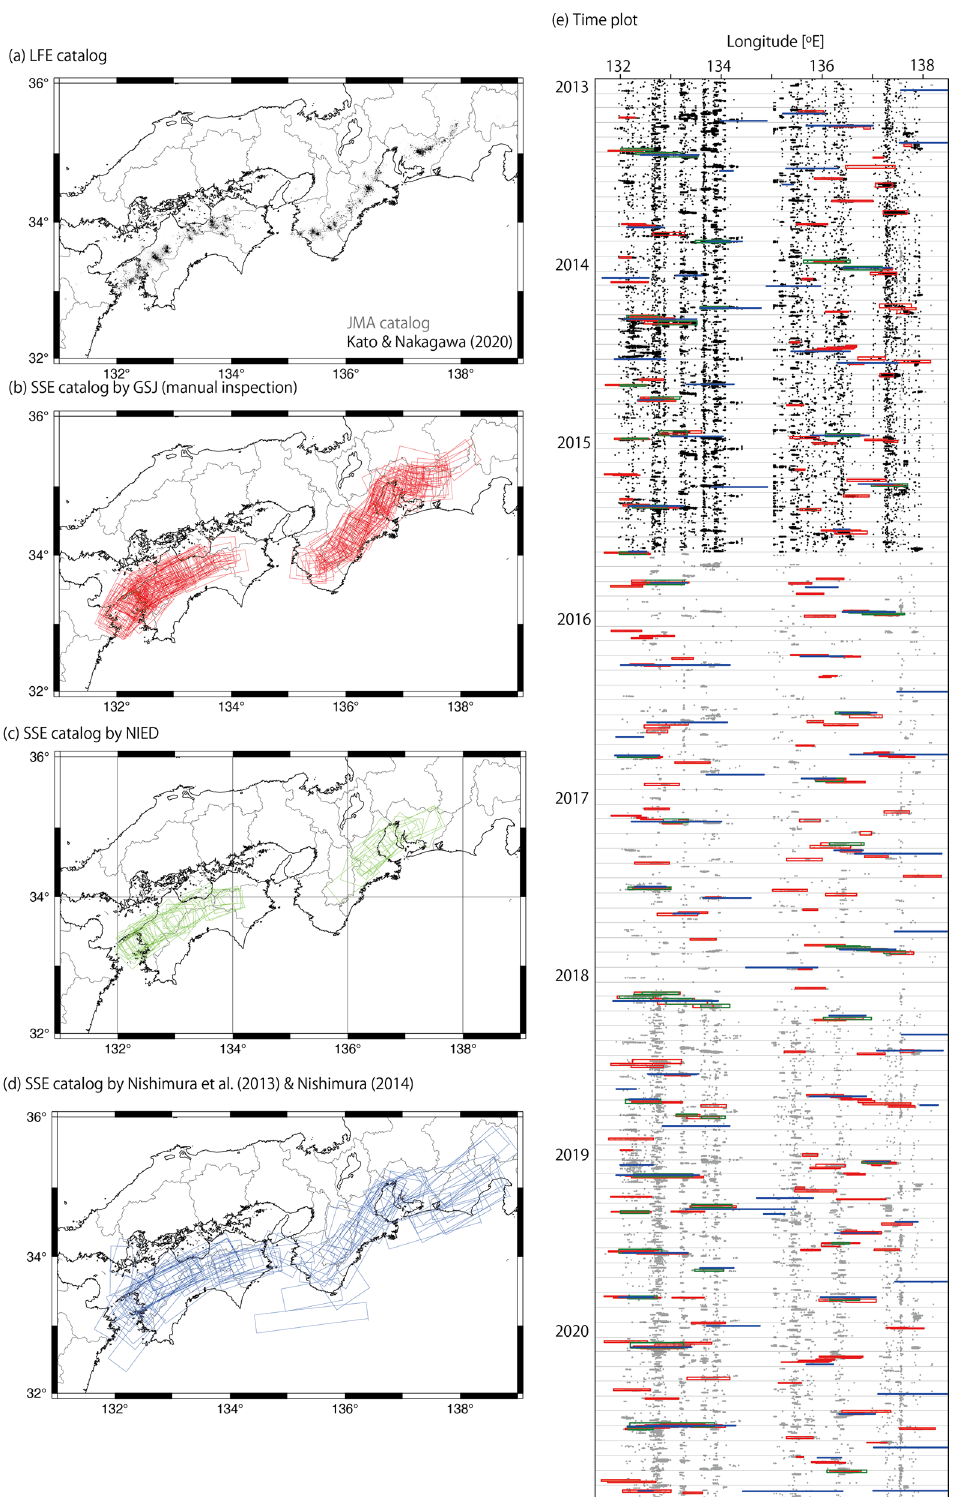
Fig. 2 LFE and SSE catalogs during 2013–2020. a LFE catalogs by JMA (gray) and Kato and Nakagawa (2020) (black). b SSE catalog by GSJ. c SSE catalog by NIED. d SSE catalog based on GNSS records (Nishimira et al. 2013; Nishimura 2014). e Time plots of events shown in a –